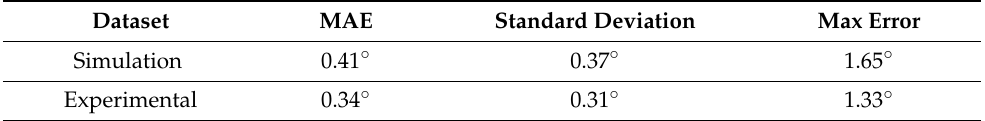
Table 5. Experimental and simulation performance evaluation of the contact angle results using the developed DL model. The model was trained purely on simulation data, but shows exceptional sim2real